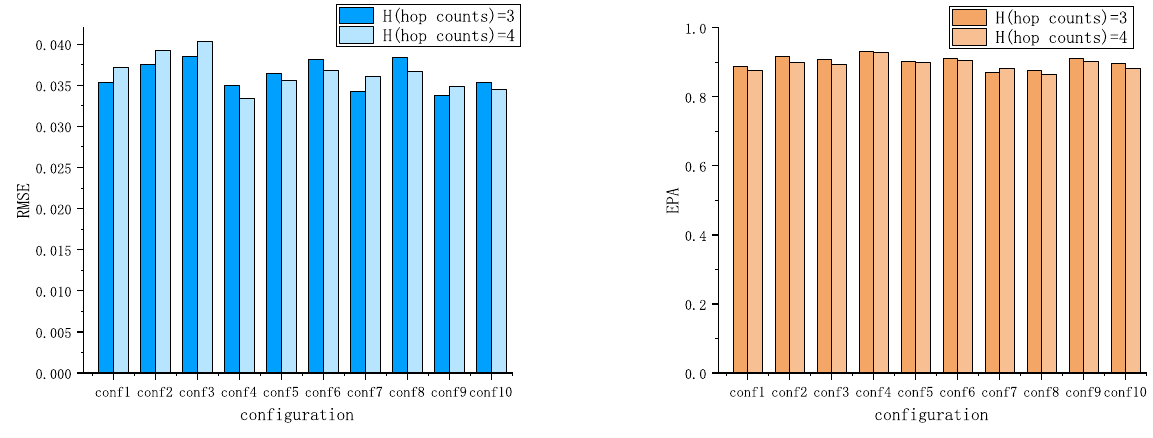
Figure 7. The prediction results for granular systems with different configurations of the disorder de- gree of 1:1. ( Left ) Root-mean-squared error (RMSE) versus configuration. ( Right ) Effective prediction accuracy (EPA) versus